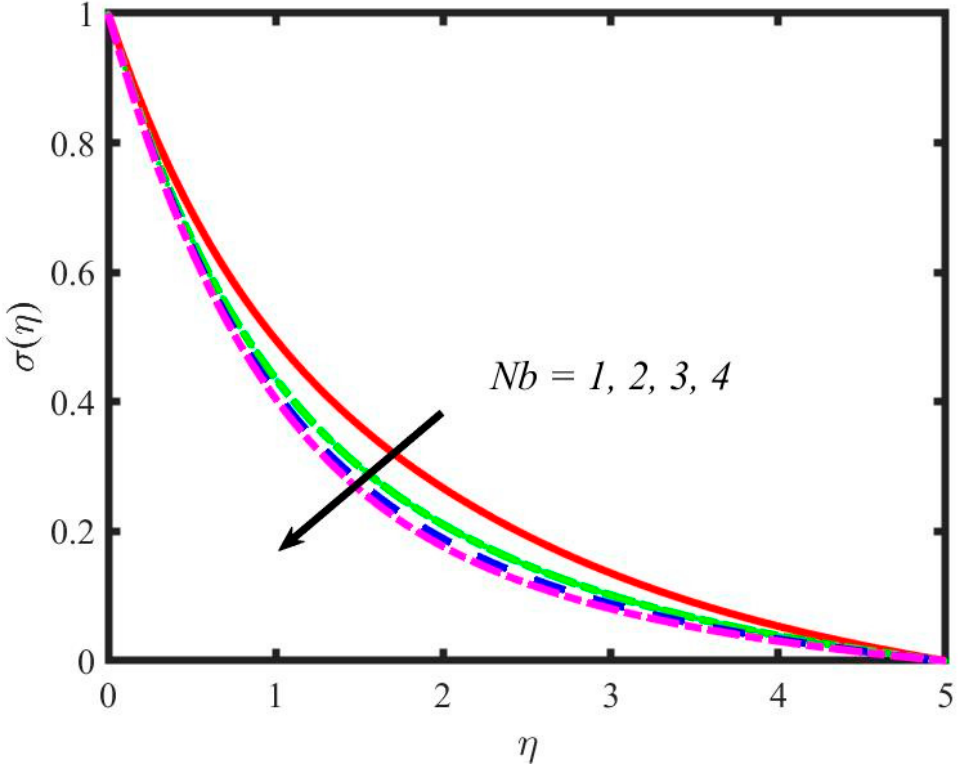
Figure 17. Variations in nanoparticle concentration for Brownian motion parameter.